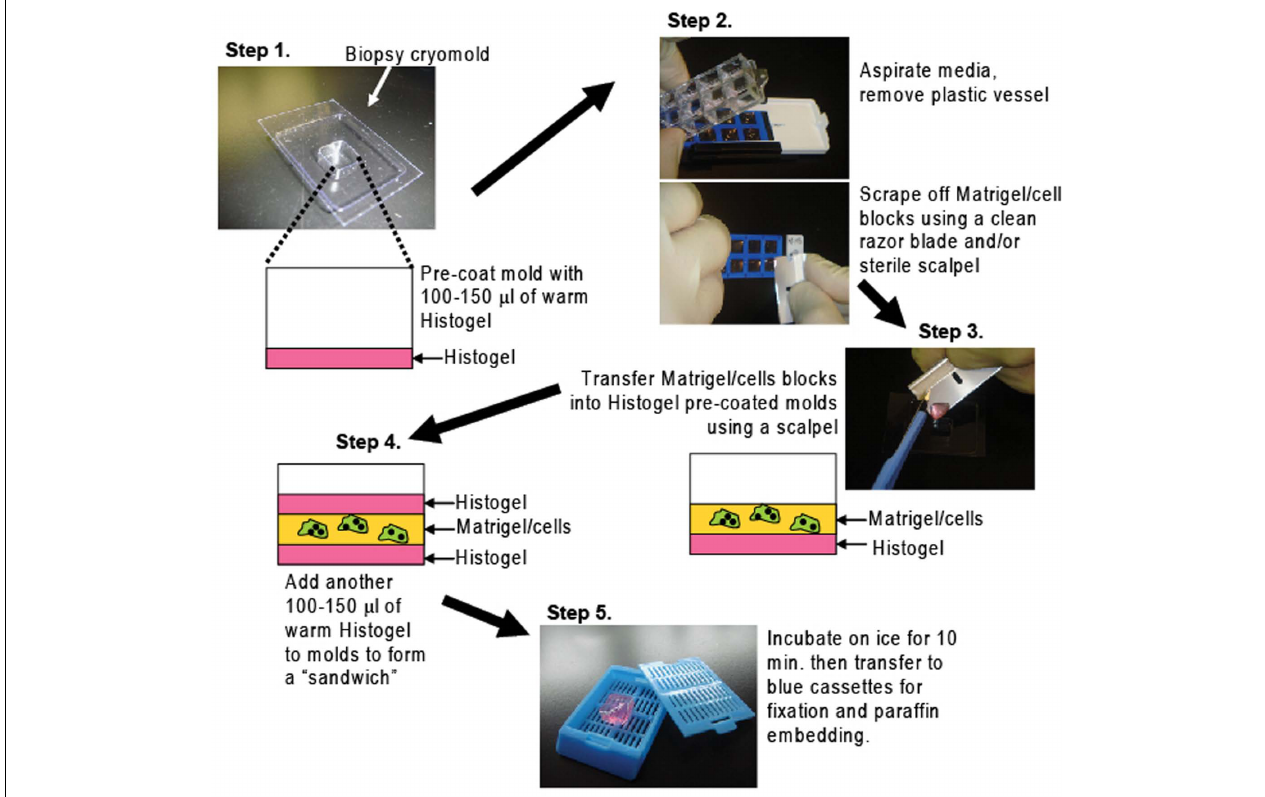
FIGURE 1 |A method to process cells grown in Matrigel for paraffin embedding. Matrigel/cell blocks are encapsulated in a Histogel “sandwich” in biopsy cryomolds then transferred to blue pathology cassettes for paraffin embedding and routine H&E or IHC analyses (details in Materials and